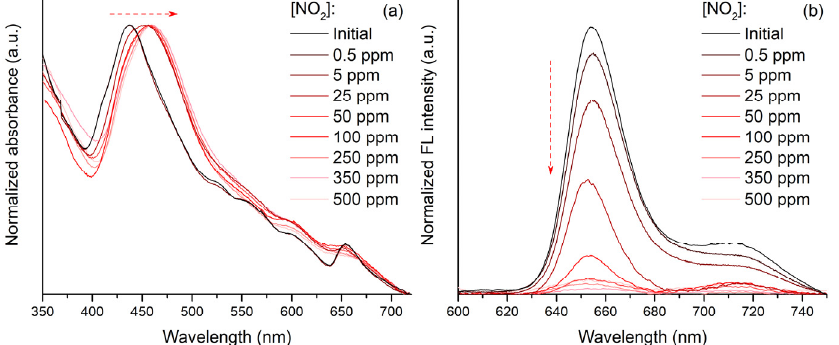
Figure 6. ( a ) Absorbance and ( b ) fluorescence ( λ exc = 415 nm) spectra of TCPC@MOF@PDMS films exposed to different NO 2 concentrations. exposed to different NO 2